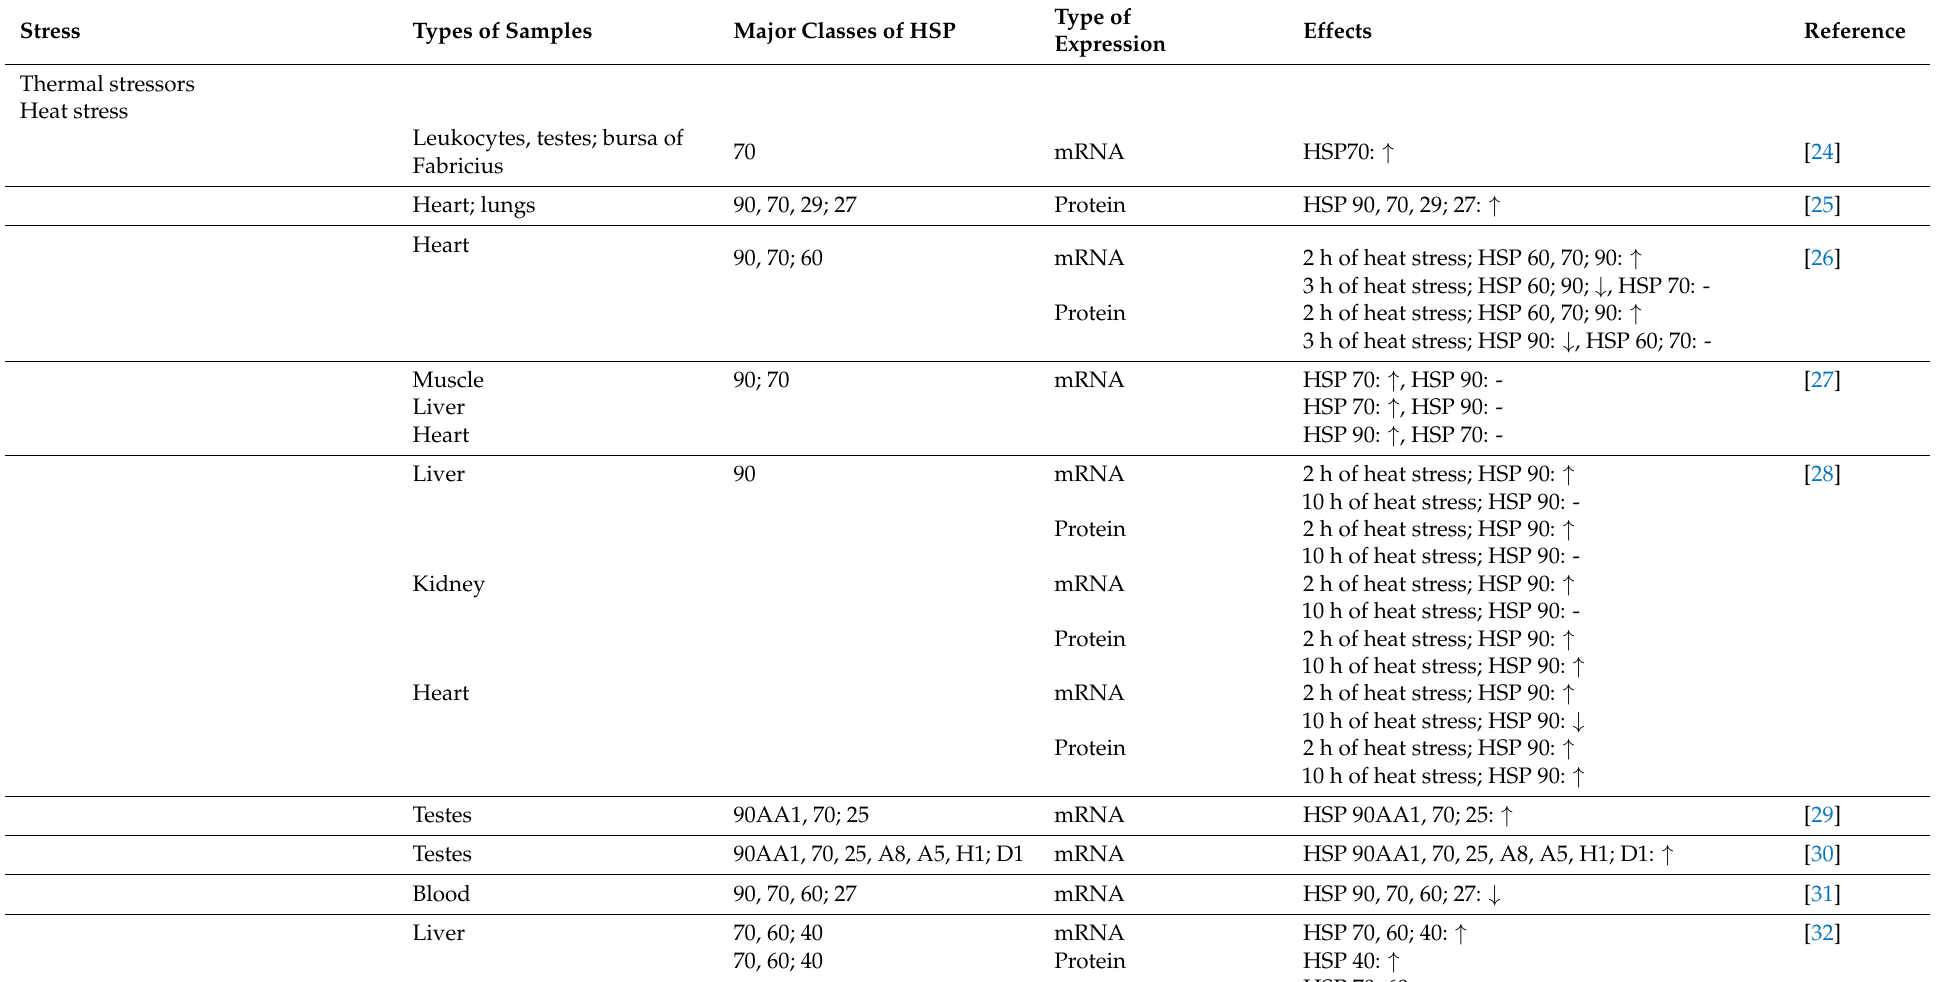
Table 1. The expression pattern of heat shock proteins associated with different major